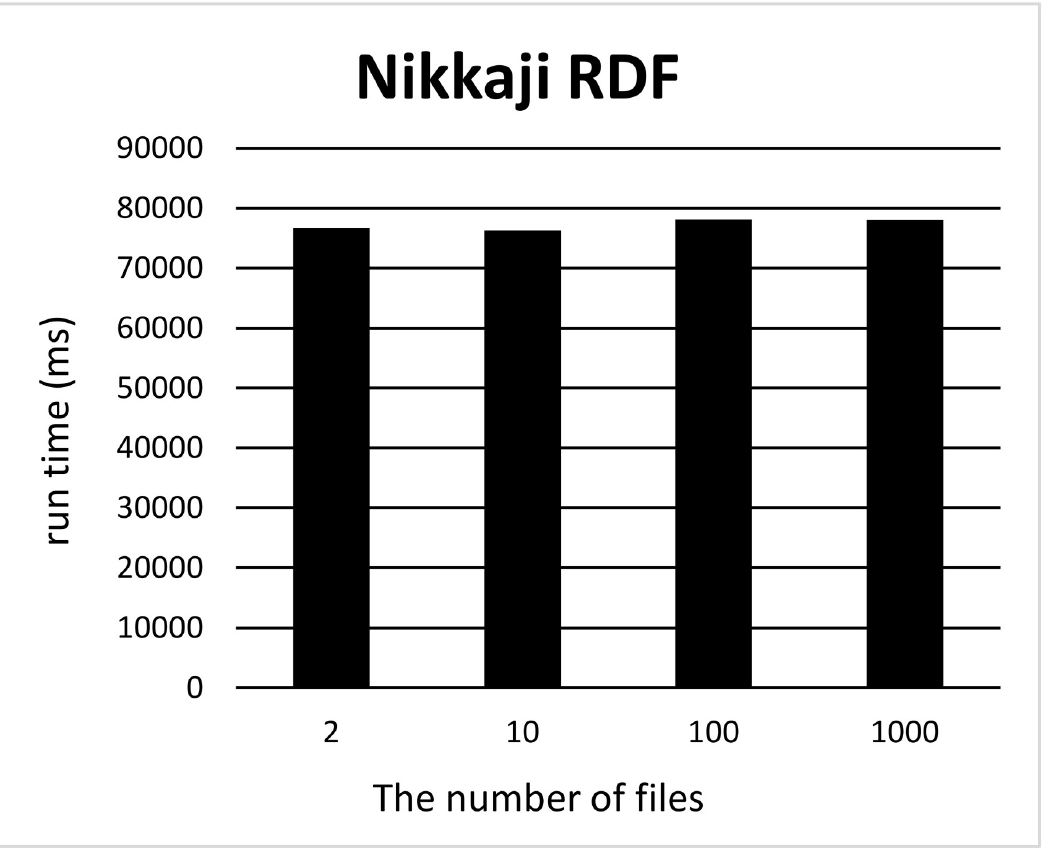
Fig 4. Computation time to split the Nikkaji dataset. x -axis and y -axis correspond to the number of files (2, 10, 100, and 1000) and the average of running time [ms],